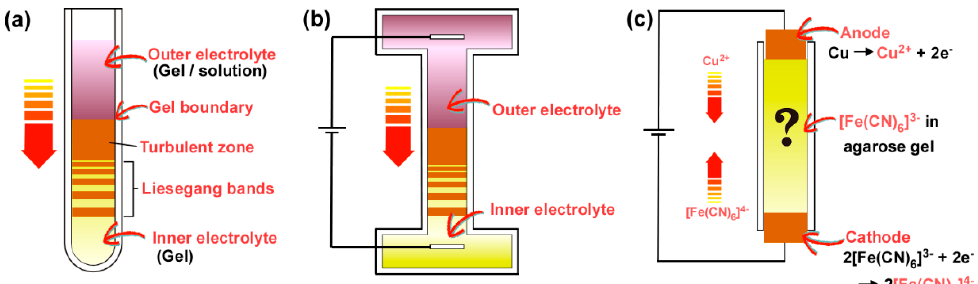
Figure 1. Schematic illustrations of the ( a ) conventional reaction–diffusion (RD) setup to observe Liesegang banding [1,4,5], ( b ) previously reported RD setup to examine the effects of electric field on Liesegang bands [8,10,11], and ( c ) currently proposed reaction–diffusion–reaction (RDR) setup where electrochemical reactions, diffusion of reactant ions influenced by electric field, and precipitation reactions are coupled to form precipitation patterns of Cu-Fe PBA in agarose gel. The arrows in ( a ) and ( b ) indicate the movement directions of reactant ions supplied from the outer electrolyte column. Note that the ion movement in ( c ) is different due to changes in the supply of reactant ions. For further discussion see the text.